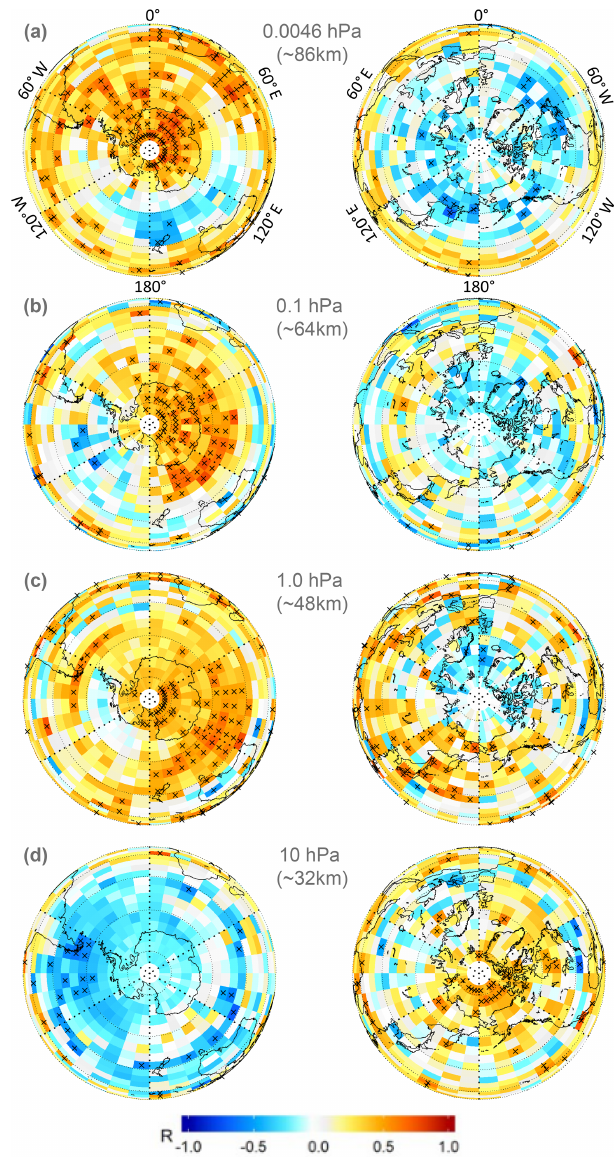
Figure 8. SH and NH projection maps of correlation between the detrended Aura/MLS 0.0046hPa, SH polar cap (65–85 ◦ S), and AMJJAS average temperature time series, with residual Aura/MLS CO mixing ratio in each grid box at the pressure levels indicated. Crosses indicate the correlation is significant at the 90%